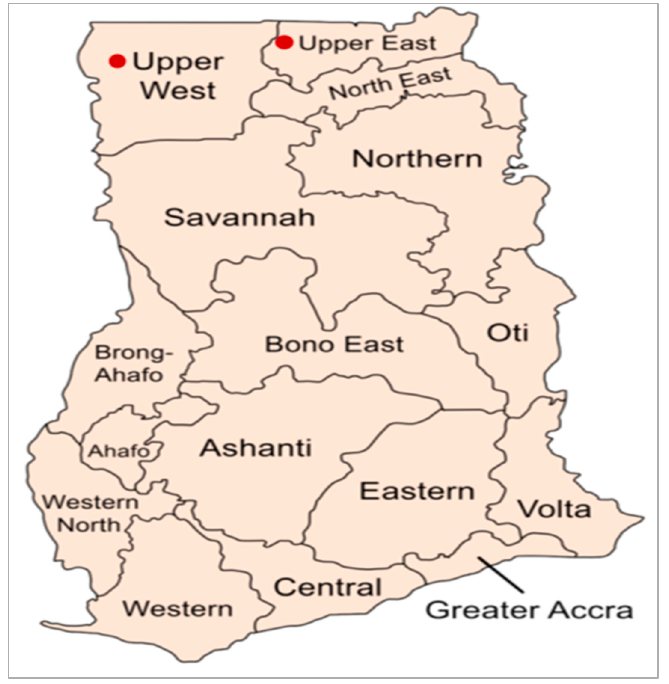
Figure 1. Map of Ghana showing the Upper East and Upper West regions. Source: [41].